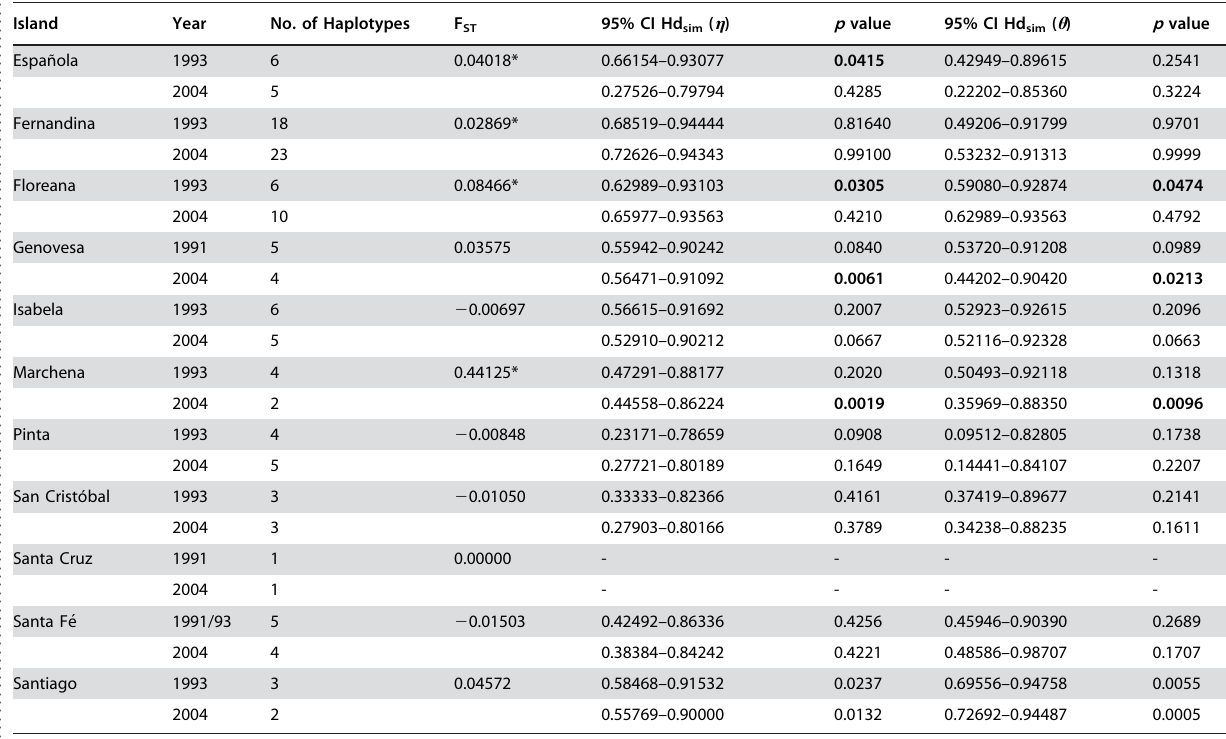
Table 2. Temporal analysis of mitochondrial control region data (1183 bp) for marine iguana populations from 11 islands.